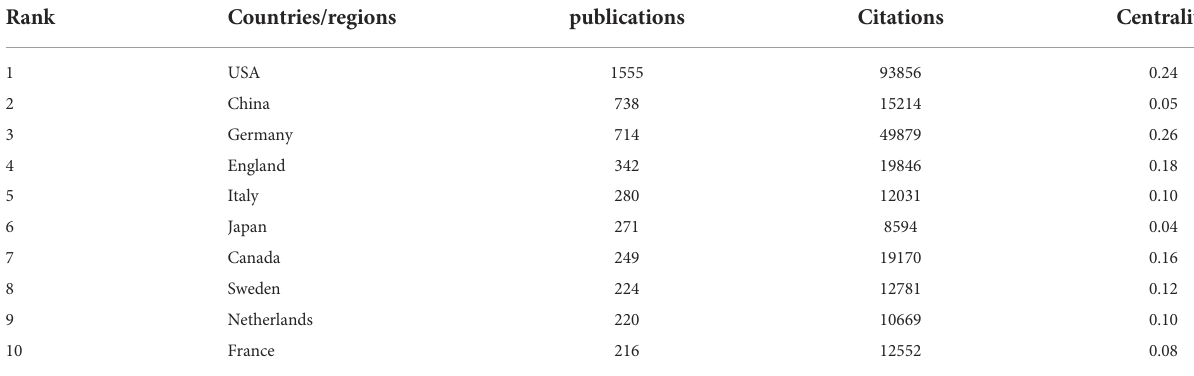
TABLE 1 Top 10 countries/regions in terms of number of publications, the corresponding frequency of citations and centrality. Rank